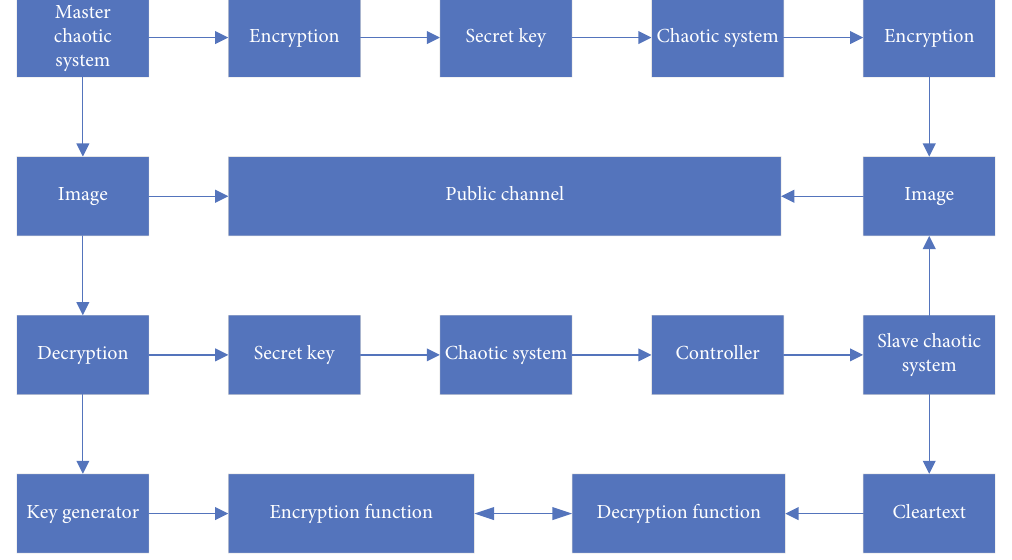
Figure 2: Chaotic encryption and decryption